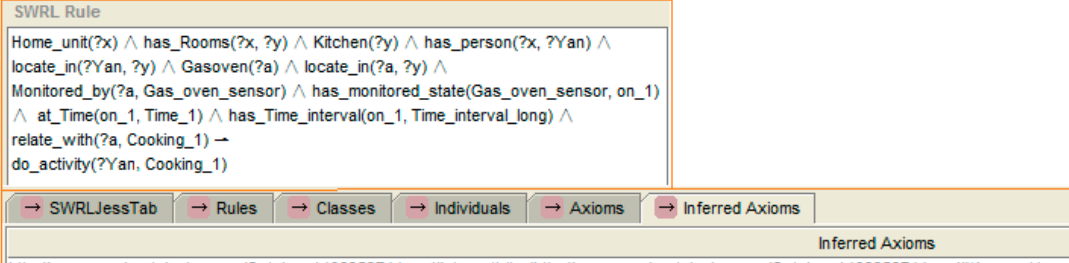
Figure 19. The reasoning process of activity “cooking”’.